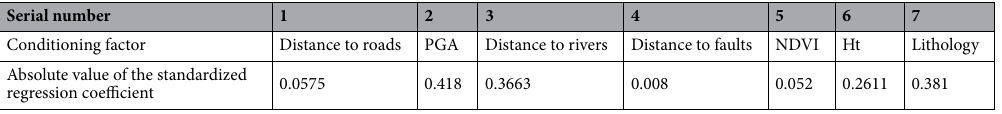
Table 2. Two-category LR coefficient results.